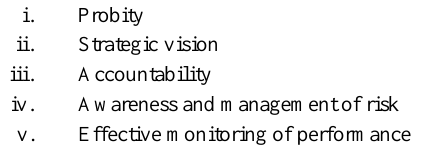
Table 1: Corporate Governance in terms of Probity